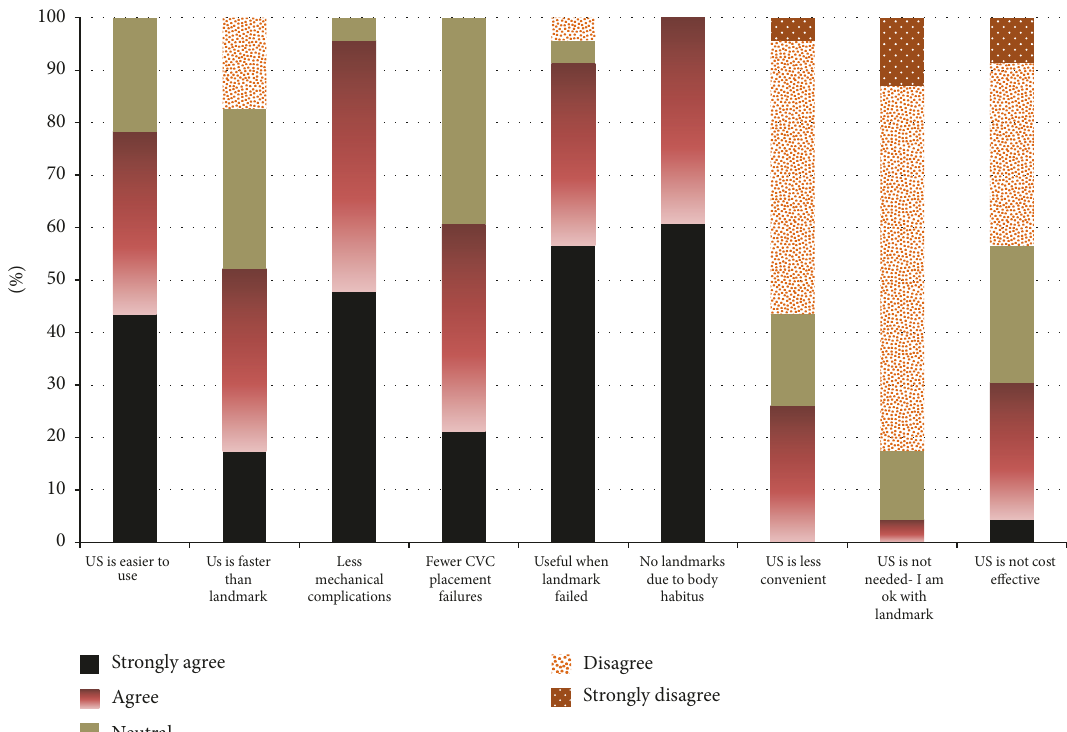
Figure 1: Distribution of participants’ answers in comparing ultrasound guidance of CVC placement with that of traditional landmark